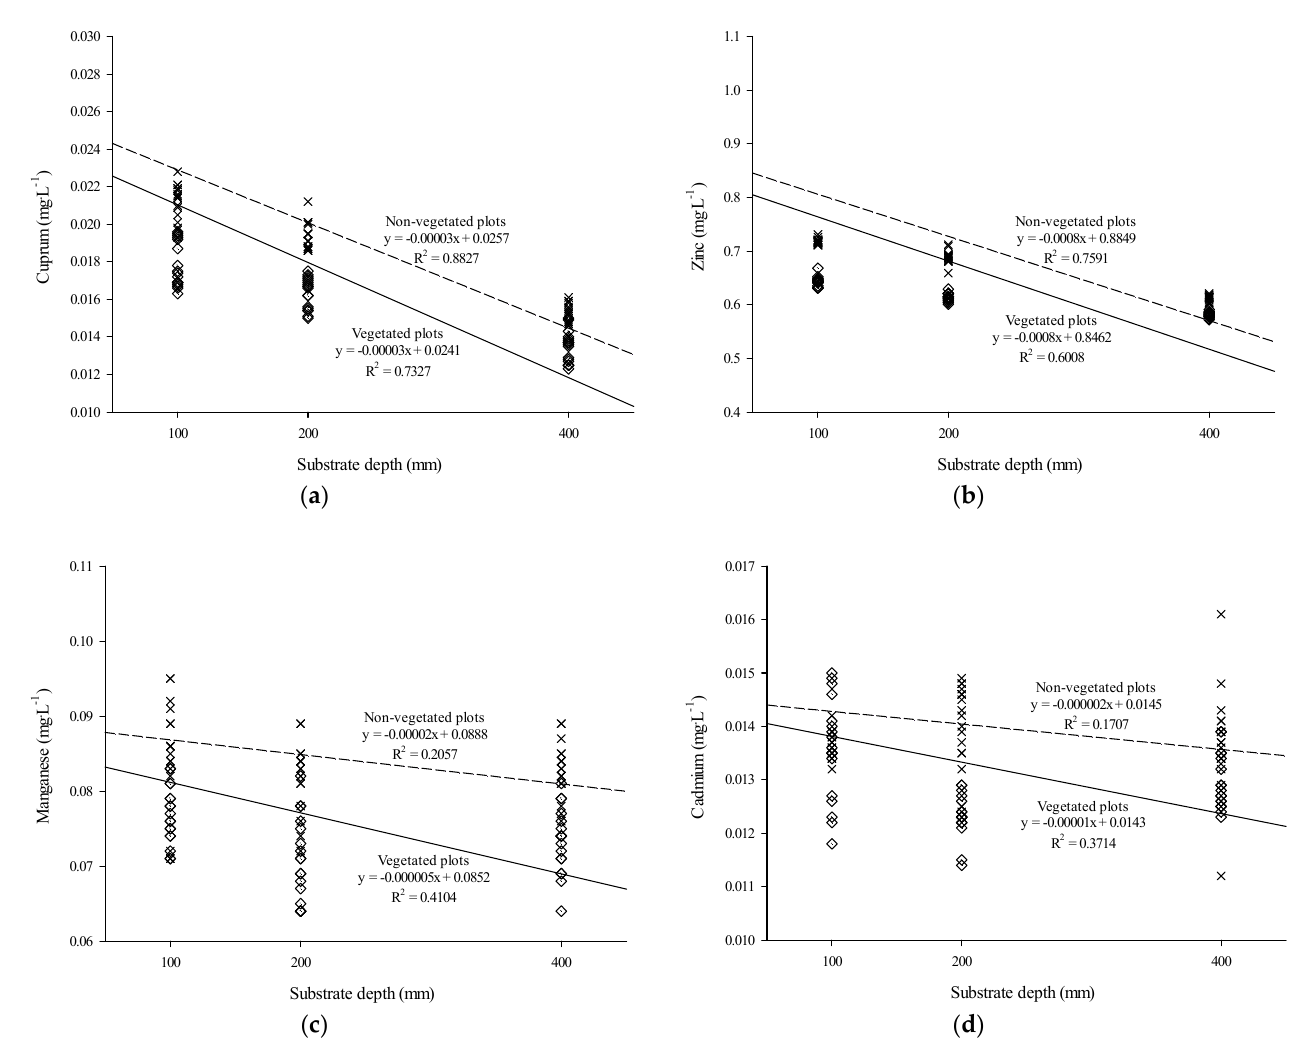
Figure 4. Relationship between substrate depth and heavy metals (Cu ( a ), Zn ( b ), Mn ( c ), and Cd ( d )) in runoff from vegetated or non − vegetated plots.